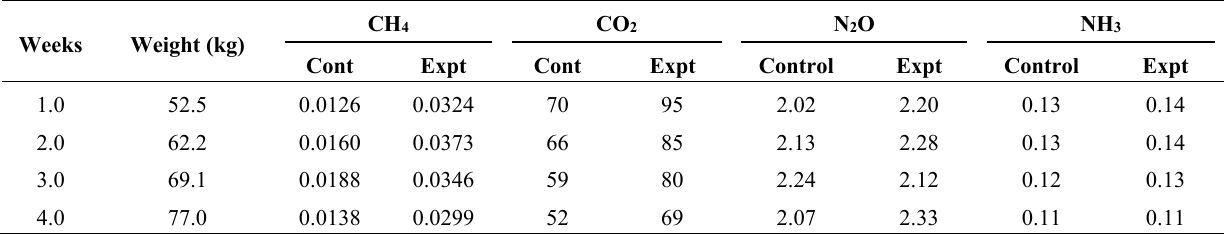
Table 7. GHG emission values for each diet treatment and growth